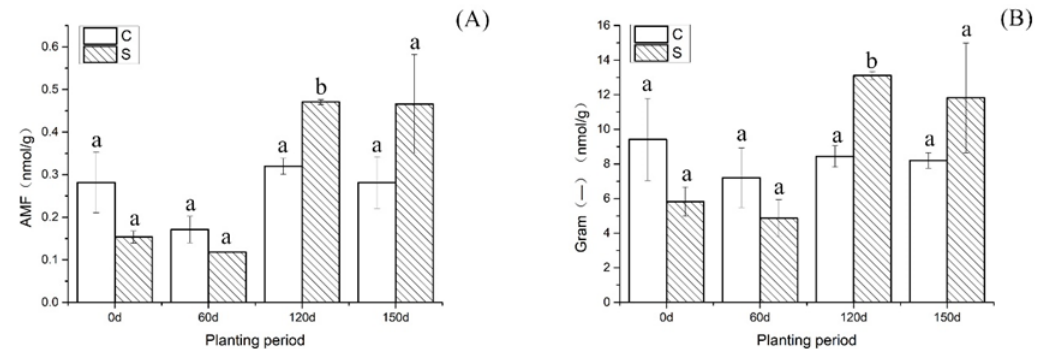
Figure 2. Changes in the total amount of phospholipid fatty acids associated with AMF ( A ) and Gram-negative bacteria ( B ) in the rhizosphere soil under high levels of PAH pollution. C, nonplanted; S, planted. Bars (means ± SD, n = 3) with different letters indicate the difference between samples in the same period ( p < 0.05).